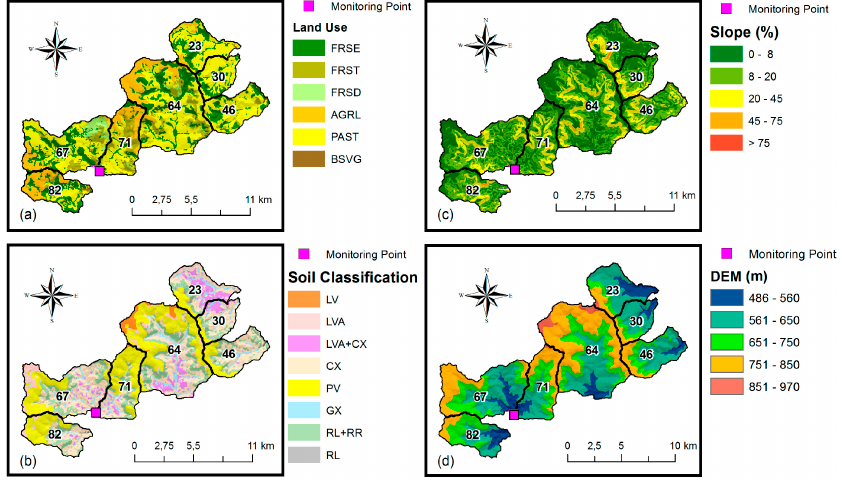
Figure 3. Study area detailed data maps ( a ) Landuse; ( b ); soils ( c ) topography; ( d )